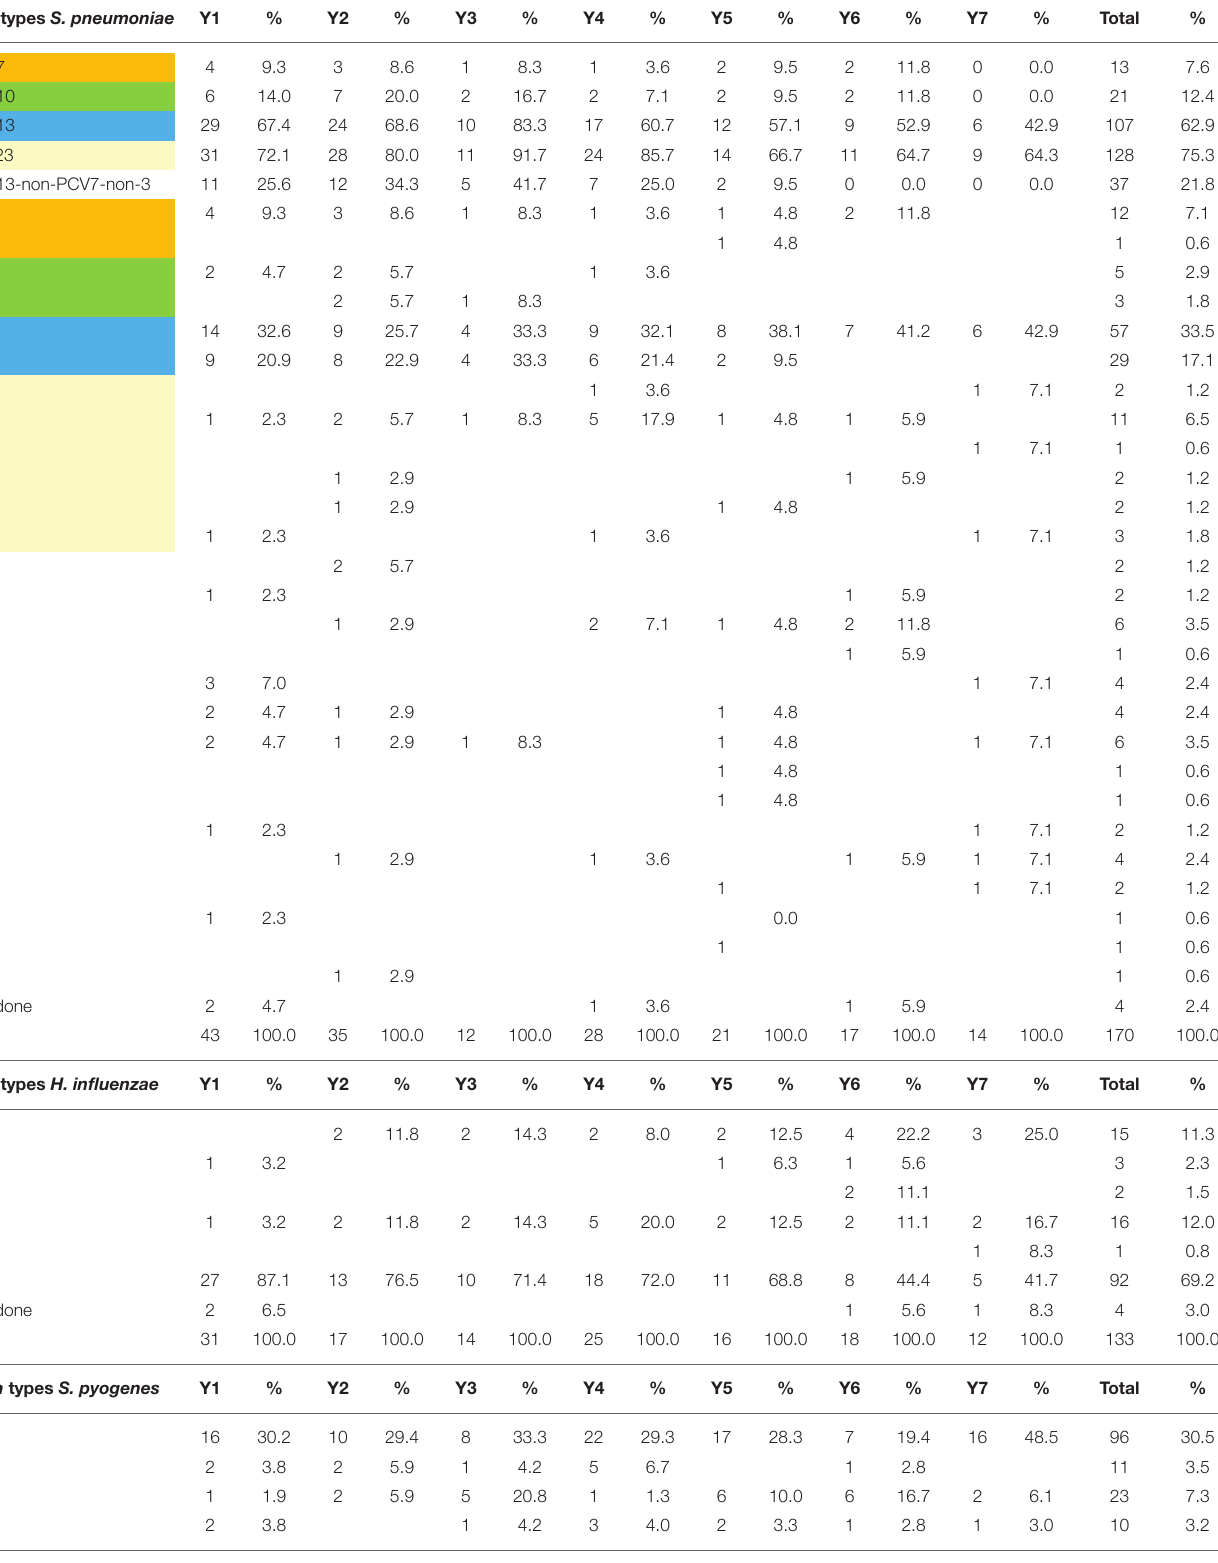
TABLE 4 | Prevalence of S. pneumoniae and H. influenzae serotypes and S. pyogenes emm types among MEF isolates over the seven study years. Serotypes S. pneumoniae